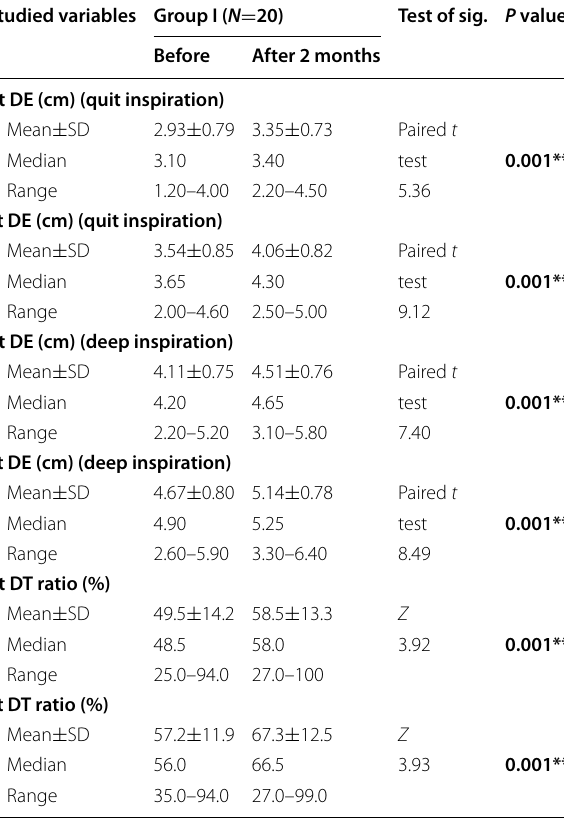
Table 6 ABG and spirometry before and after 2 months of IS use and medical treatment among group I ( N